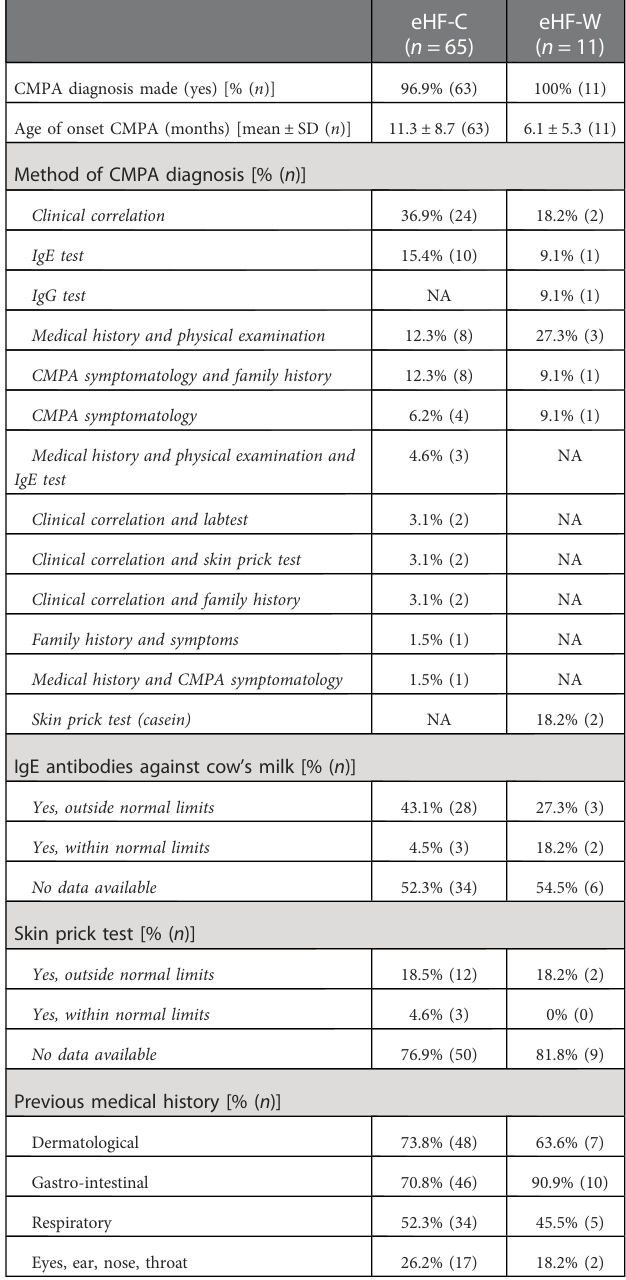
TABLE 4 Characteristics of the medical history (including CMPA diagnosis) of the study subjects in both groups: eHF-C ( n = 65) and eHF-W ( n = 11).